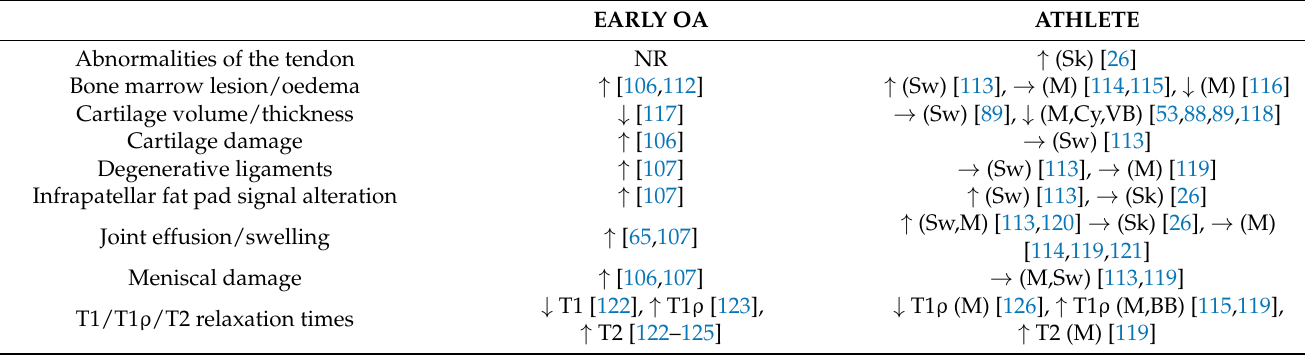
Table 2. Magnetic resonance imaging markers of early osteoarthritis and of exercise/training in athletes. EARLY OA ATHLETE Abnormalities of the